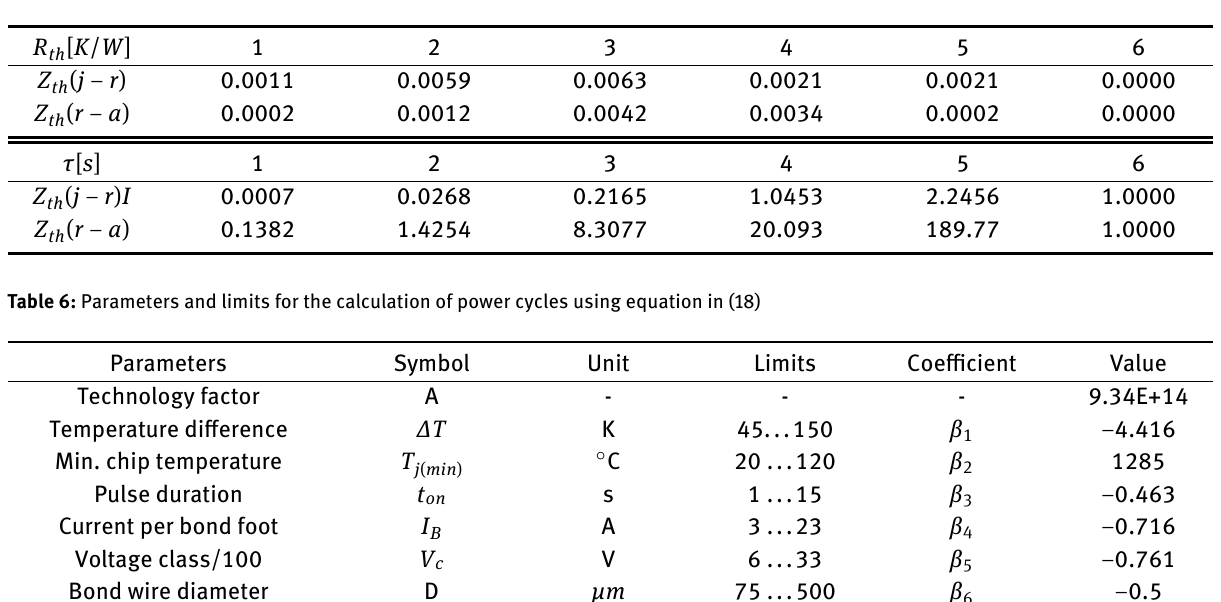
Current per bond